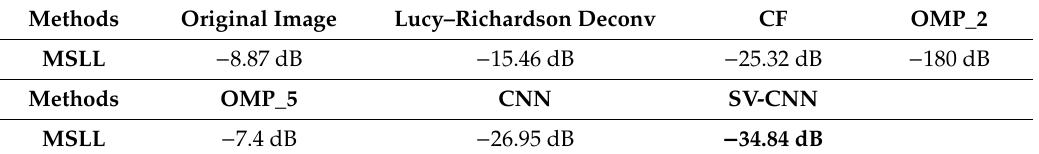
Figure 16. Imaging scene and radar images. ( a ) Imaging scene; ( b ) the original image; ( c ) the enhancing result of Lucy–Richardson algorithm; ( d ) the result of the CF algorithm; ( e ) the enhancing result of the OMP with the sparsity of 2; ( f ) the enhancing result of the OMP with the sparsity of 4; ( g ) the enhancing result of the CNN; ( h ) the enhancing result of the SV-CNN. Table 3. MSLL comparison of the above different methods on real recorded images.